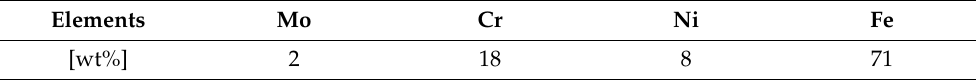
Table 1. Elemental composition of the austenitic stainless steel substrate 18/8. Elements Mo Cr Ni Fe [wt%] 2